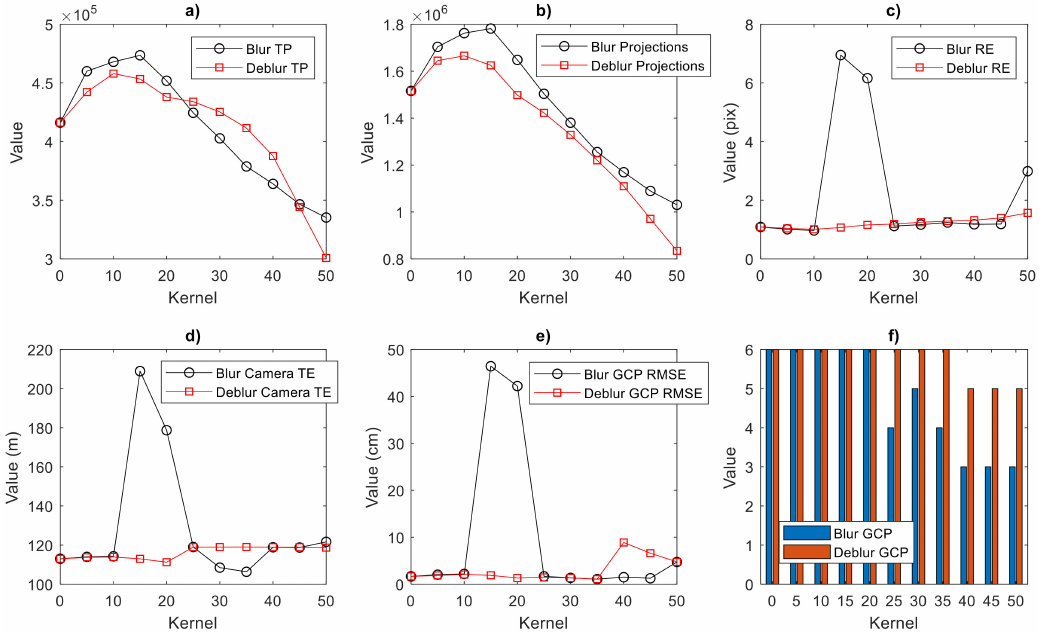
Figure 7. Comparison of reported survey data for blurred and deblurred data set: ( a ) the number of tie points; ( b ) the number of projections; ( c ) reprojection error (pix); ( d ) camera location total error (m); ( e ) GCP total RMSE (cm); and ( f ) the number of marked